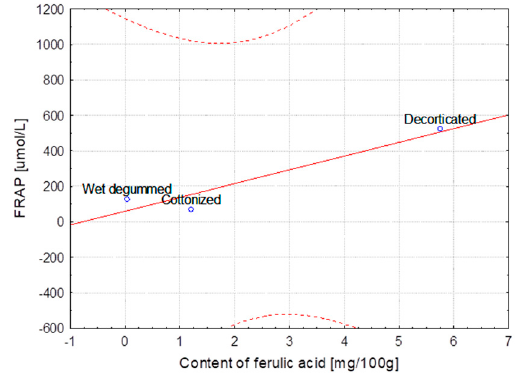
Figure 4. Variety of flax MODRAN—Dependence of FRAP [ μ mol/L] vs. content of ferulic acid [mg/100 g] (y = 60.187 + 77.556x; C = 95%).